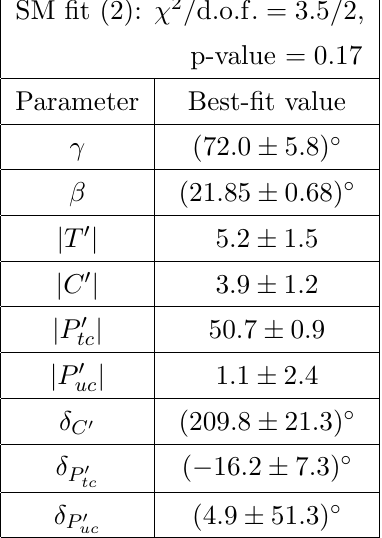
Table 3 . (cid:31) 2 = d : o : f : and best-(cid:12)t values of unknown parameters in amplitudes of eq. (2.1). Con- min straints: B ! (cid:25)K data, measurements of (cid:12) and (cid:13)